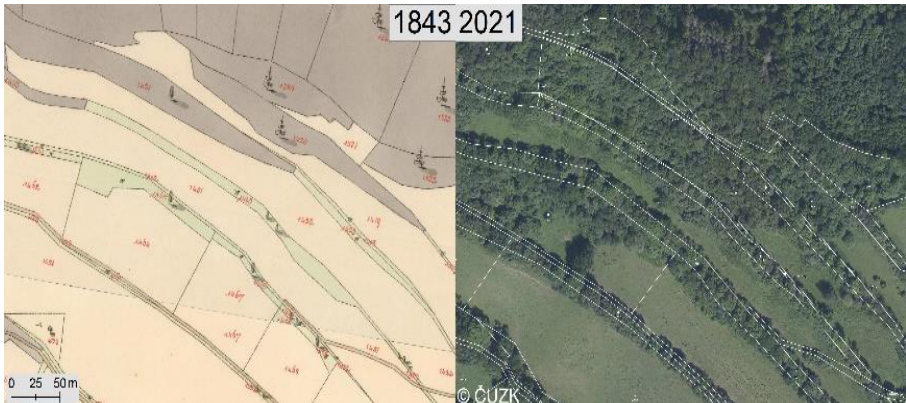
Figure 6. Cross-border site of the former villages of Mohelnice (Czechia, Germany) and Fürstenau (Germany) in the Krušné Hory Mts on a map of the Second Military Survey: red circles indicate location of HALs map signs. [data sources: Arcanum Maps — Europe in the XIX. century: Adapted with permission from Refs. [72,73]].